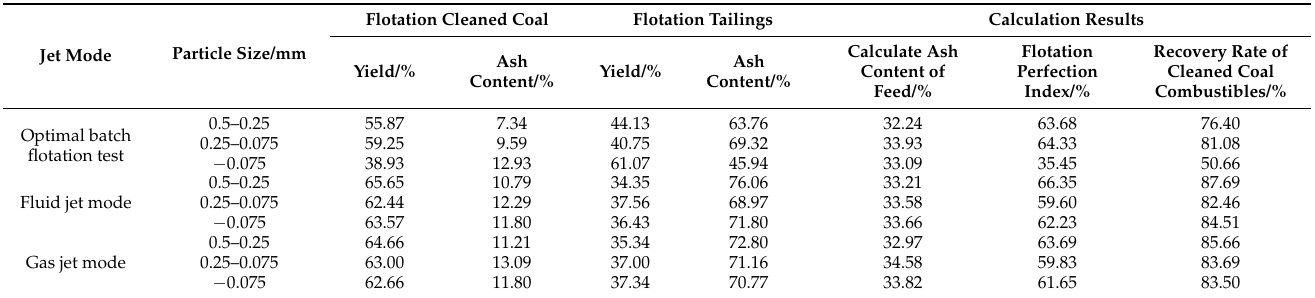
Table 1. Test results of coal slime flotation mixing performance.